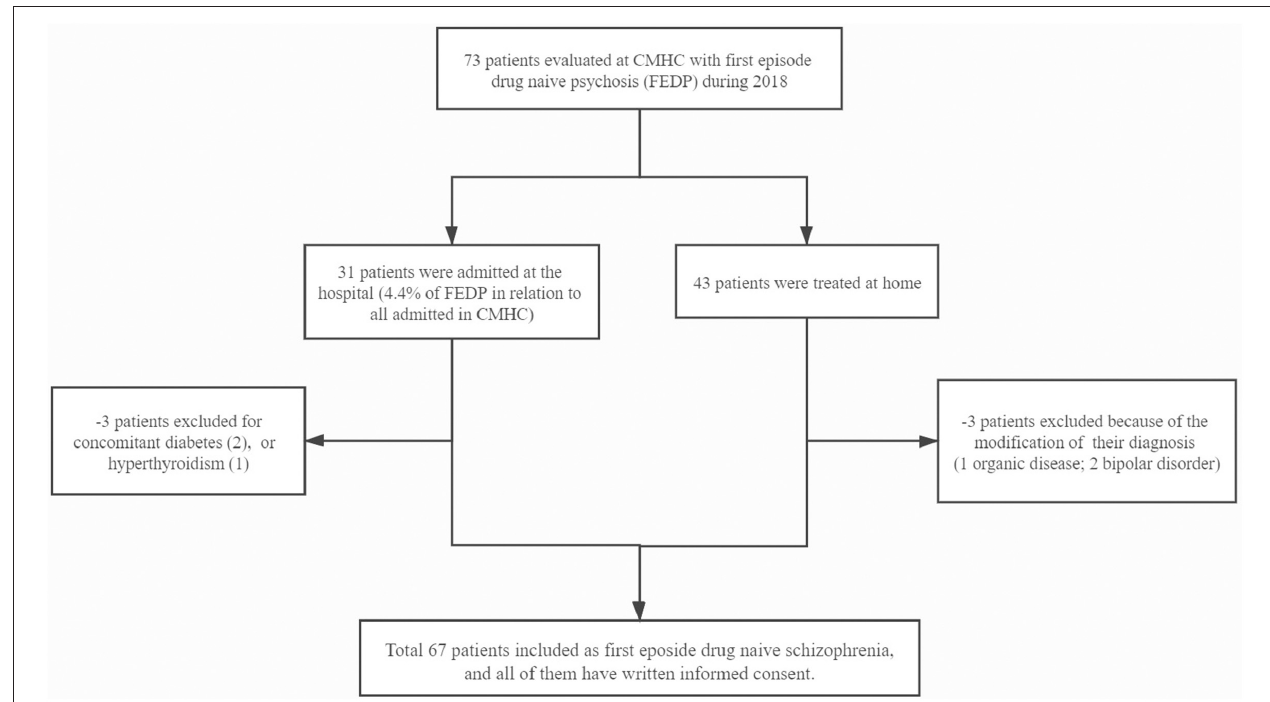
FIGURE 1 | Flow chart of the inclusion and exclusion of patients (Chengdu, China,